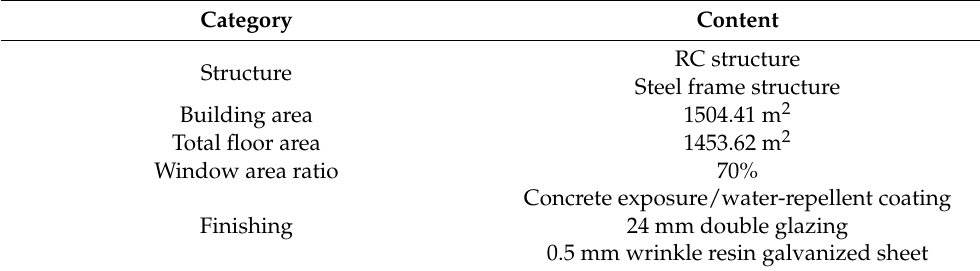
Table 1. Details of the target building.